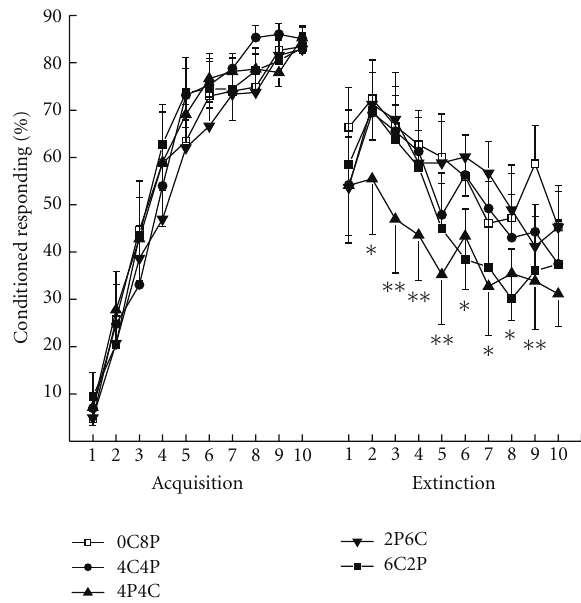
Figure 6: Mean percent conditioned responding during 10 days of Acquisition and 10 days of tone-alone Extinction separated by 8 weeks on a specific diet. The 6CP2, 2PC6, 4C4P, 4P4C, and 0C8P group designations refer to the number of weeks out of eight the rabbits were on either a 2% cholesterol diet (C) or on normal Purina rabbit chow (P). The order of the letters and refers to order in which rabbits received their respective diets. ∗ P < . 05, ∗∗ P < .